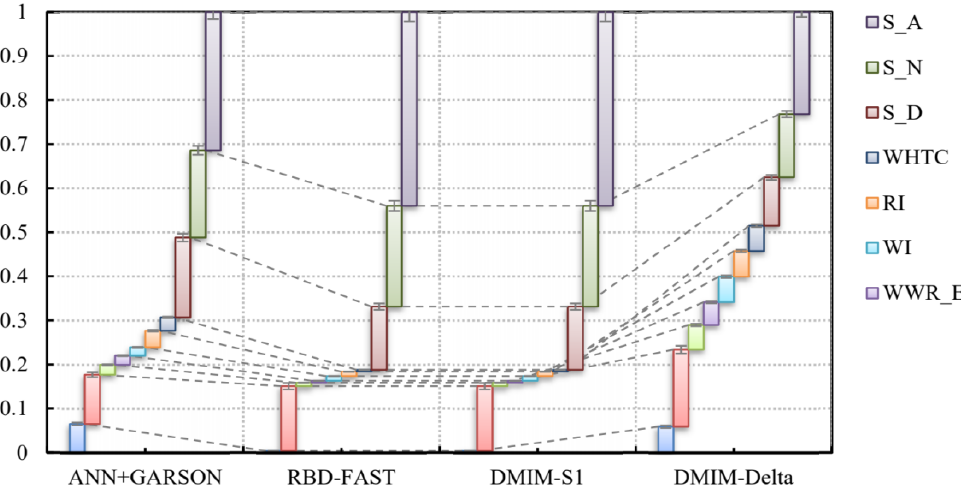
Figure 2. Sensitivity analysis of shading components.